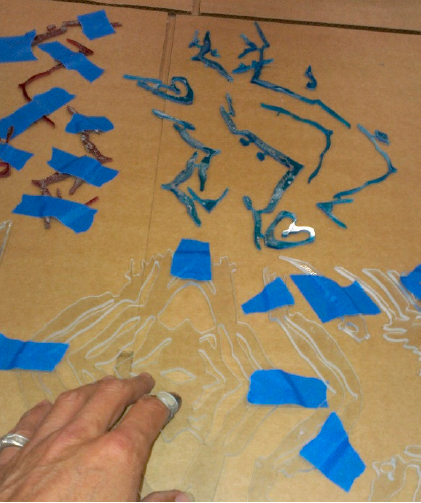
Figure 4. Water-jet cut glass parts, tabs and abrasive residue visible. [Created by author].